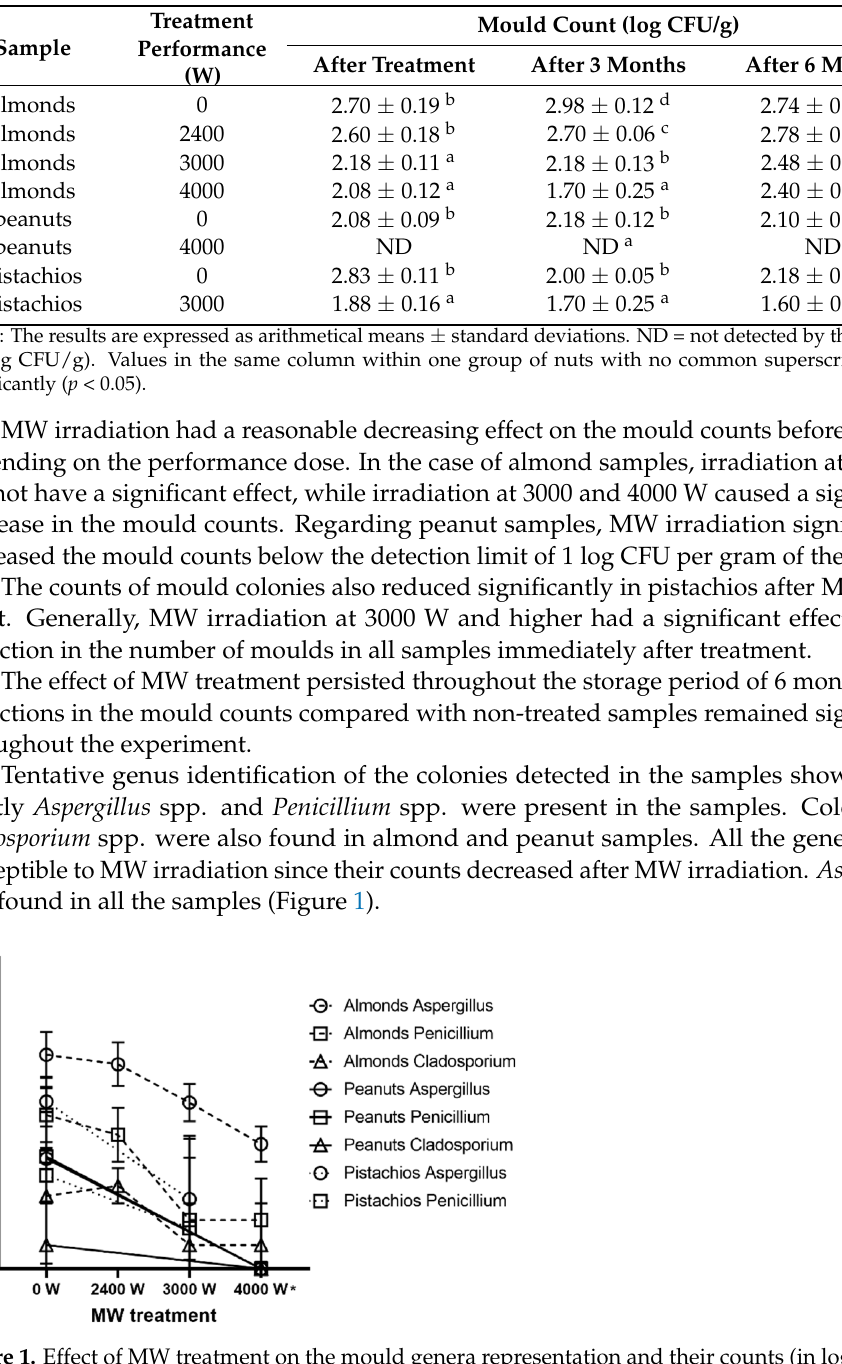
Table 1. Effect of MW treatment on mould counts during the storage of almonds and nuts.